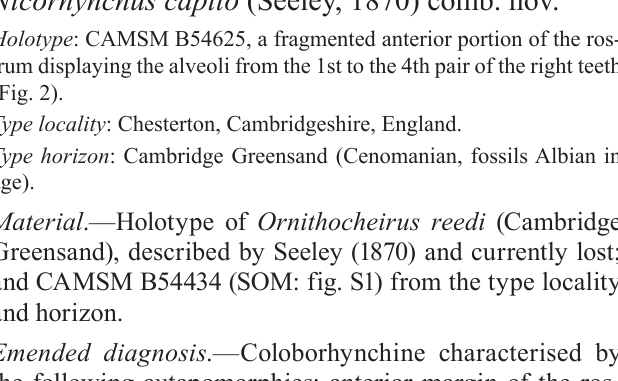
Fig. 2. Anhanguerid pterosaur Nicorhynchus capito gen. et comb. nov. (ho­ lotype), CAMSM B54625, Chesterton, Cambridgeshire, England, Albian. In anterior (A 1 ), right lateral (A 2 ), palatal (A 3 ), and left lateral (A 4 ) views. A 1 and A 3 modified from Rodrigues and Kellner (2013), A 2 and A 4 pho­ tographs by